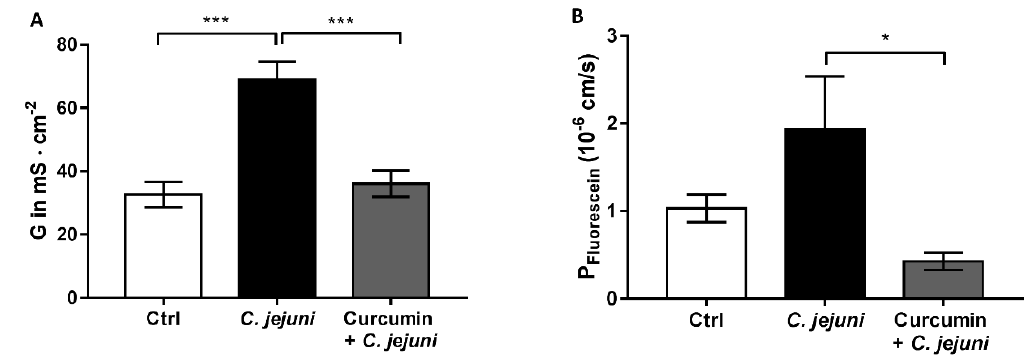
Figure 4. Curcumin ameliorates the C. jejuni -induced barrier dysfunction in colon of IL-10 −/− mice.